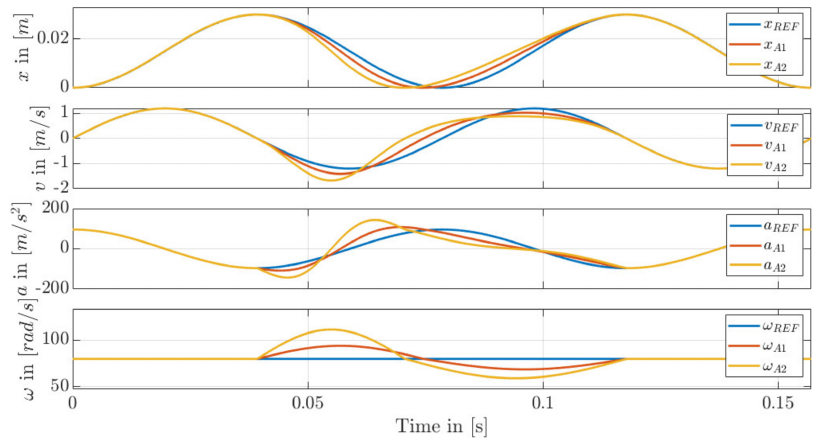
Figure 10. Comparison between the reference curve and dead center shift in the operating point ω = 80 rad , x peak = 0.03 m, T 1 = 0.25 · T p , T 2 = 0.225 · T p , T 3 = 0.275 · T p and ω = 80 rad s x peak = 0.03 m, T 1 = 0.25 · T p , T 2 = 0.2 · T p , T 3 = 0.3 · T p .